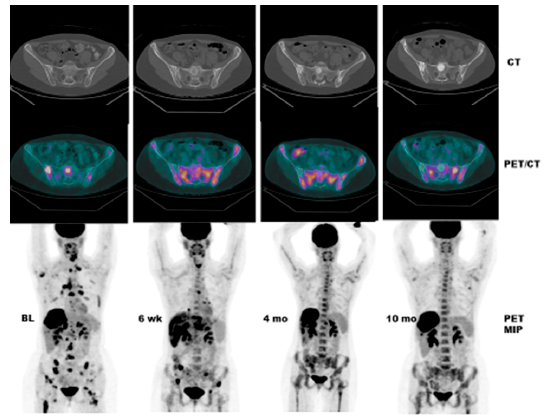
Figure 2. Pre- and Post FDG PET in a 47 y/o female with metastatic breast Cancer and multiple osseous metastases. Baseline study shows focal sites of activity in the bone marrow space, without discernible anatomic abnormality. About 6 weeks after starting therapy, there is diffuse marrow activation; however, there is relative loss of normal marrow activity where tumor was previously seen, and there is new sclerotic change at those sites. About 4 months after starting therapy, there is still diffuse marrow activation with loss of normal marrow activity where tumor was, and increased sclerosis on CT images. Unfortunately, about 10 months after starting therapy, she relapsed, with new focal sites of activity, without anatomic abnormality (similar to baseline study), whereas previously tumor sites have become densely sclerotic and remain without activity to suggest active tumor.